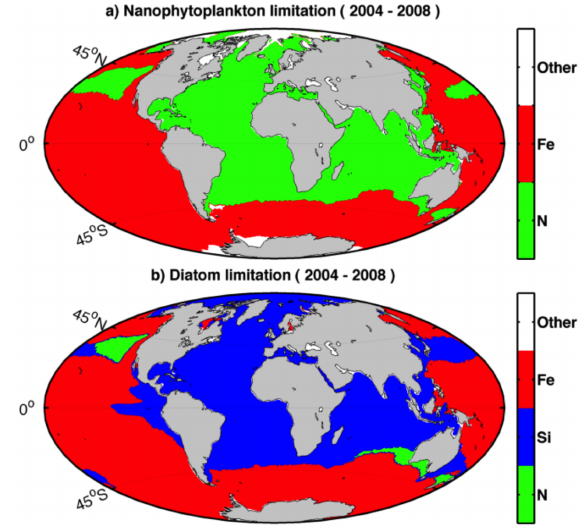
Figure 10. Following the example of Schneider et al. (2008), the spatial distribution of the annually mean limiting nutrients in the model’s surface water has been calculated. (a) Nanophyto- plankton (Fe = 56.6%, DIN = 40.1% of total area). (b) Diatoms (Fe = 53.6%, DIN = 2.5% and DSi = 43.8% of total